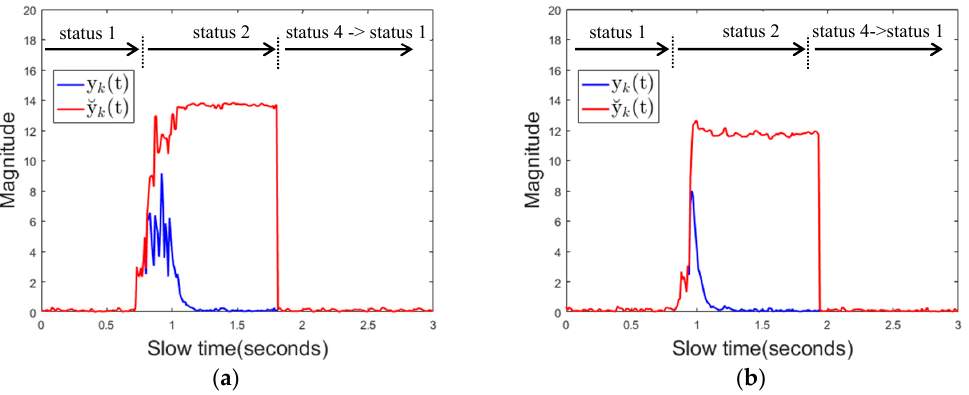
Figure 21. The maximum value of the received over slow time when there is a background change ( a ) water bottle (appearing) ( b ) water bottle (disappearing)